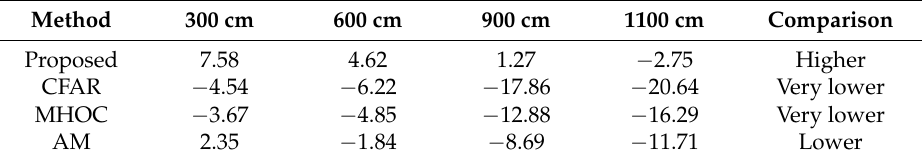
Table 2. SNR (dB) versus range for different algorithms.